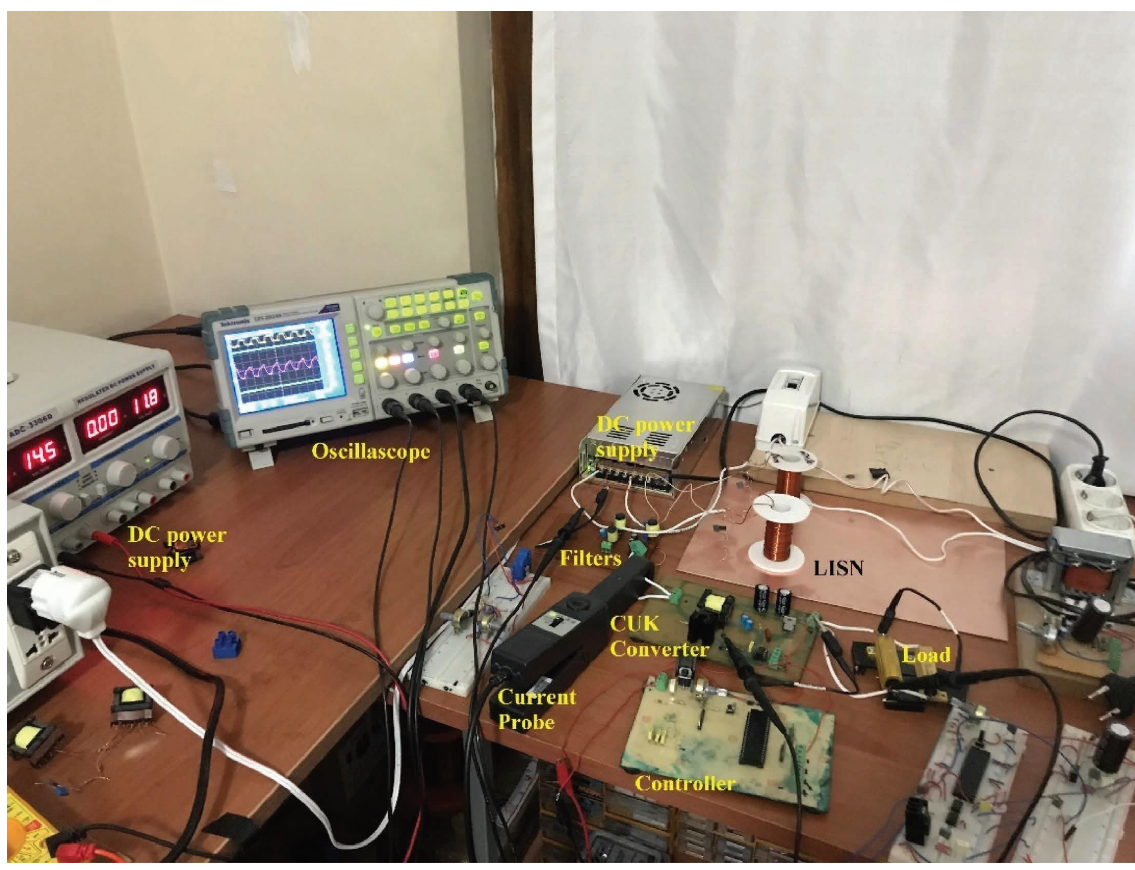
Figure 8: Application environment. Table 1: Passive components used in